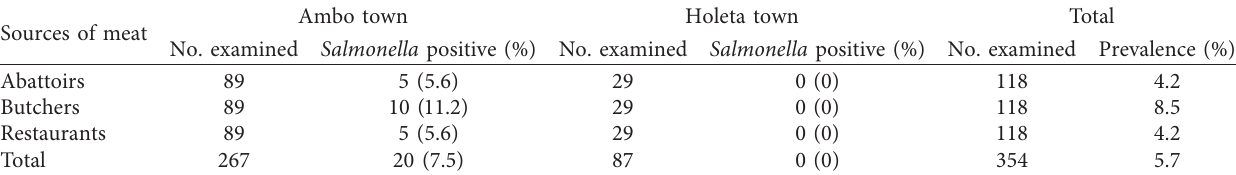
Table 1: Prevalence of Salmonella in abattoirs, butchers, and restaurants of Ambo and Holeta towns. Sources of meat